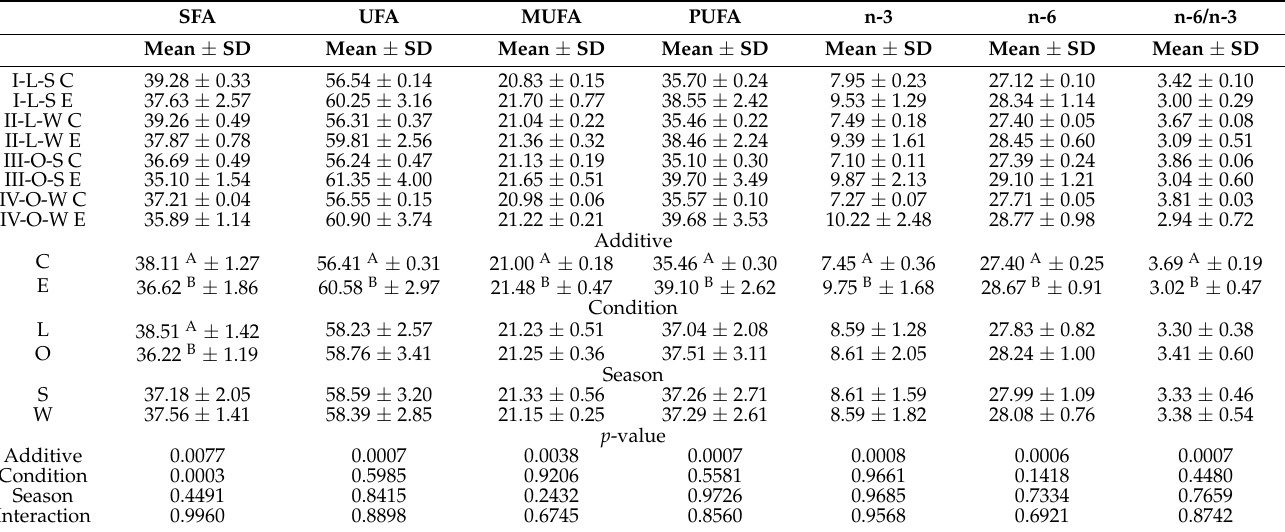
Table 6. Fatty acid profile of rabbit blood